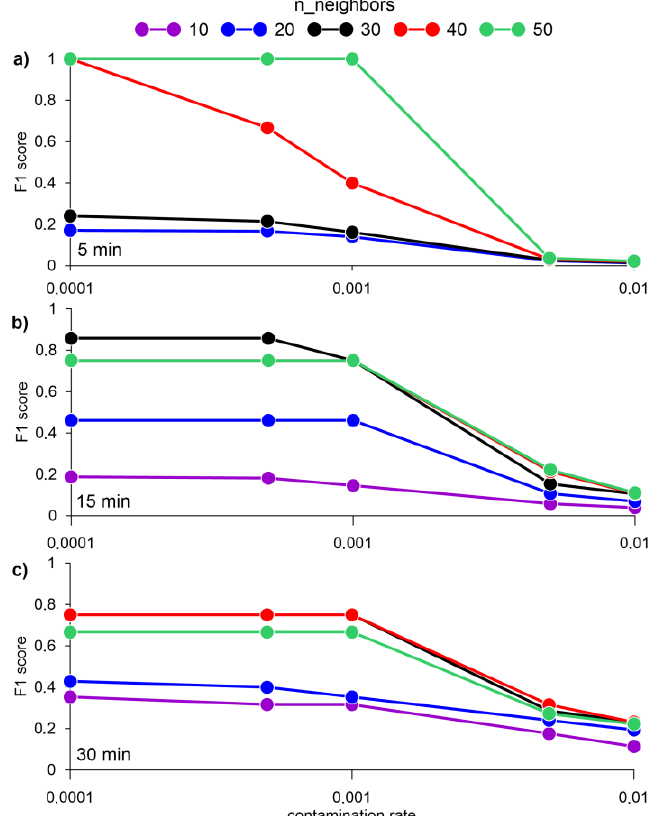
Figure 7. F1 score for a different number of nearest neighbors k and averaging data for 5 ( a ), 15 ( b ), and 30 min ( c ), obtained by the LOF algorithm.